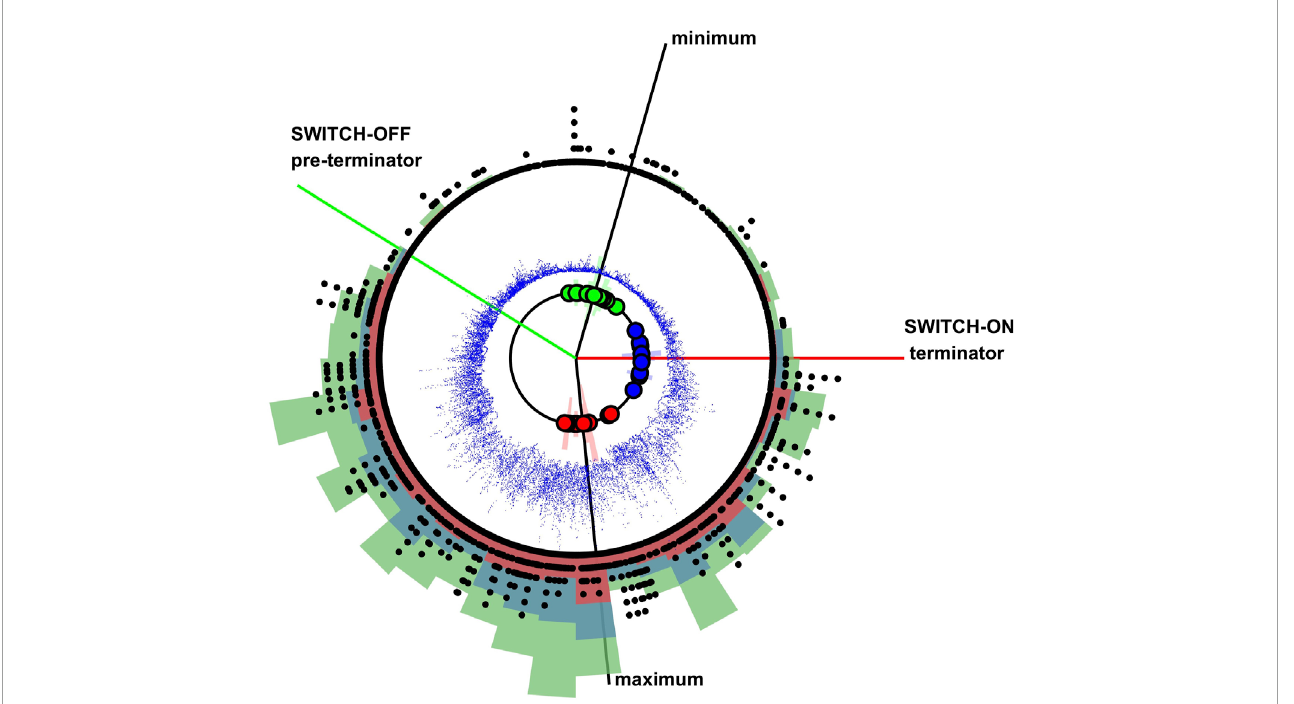
FIGURE 2 Solar cycle clock. Increasing time (analytic phase) is read clockwise. The clock shown is obtained from the daily sunspot number record since 1818. Analytic phases of the maxima and minima of the last 18 solar cycles are indicated by red and green circles respectively and the blue circles indicate terminators for the last 12 solar cycles (McIntosh et al., 2019). Black lines indicate the average analytic phase for the maxima and minima. A red line indicates the average analytic phase of the terminators. The pre-terminator (green line) is at a phase − 4 π / 5 w.r.t. the terminator. Black dots arranged on concentric circles where increasing radius indicates aa values which in any given day exceeded 100, 200, 300, 400, 500, 600 nT . Blue dots overplot daily F10.7 and overplotted red, blue and green histograms show counts in non-overlapping (normalized) 3-month long bins for X-class, M-Class and C-class flare occurrence (scaled relative to each other in ratio